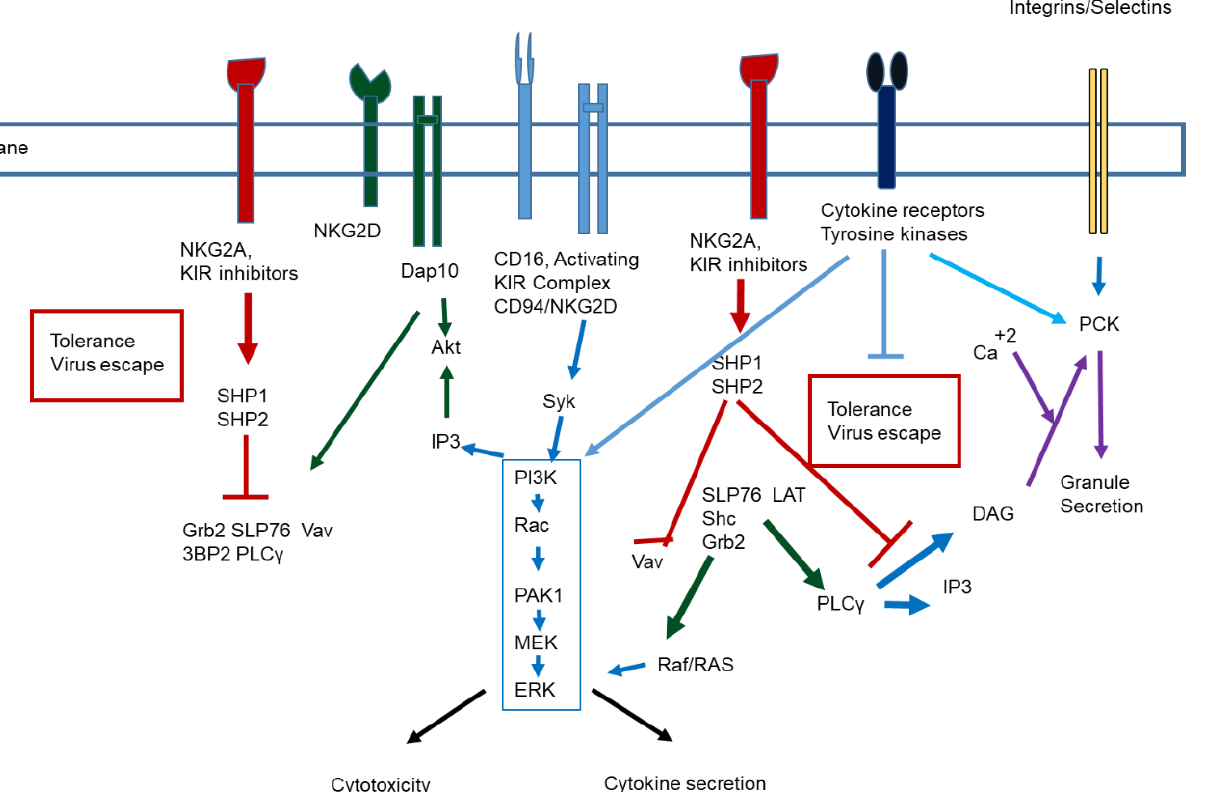
Figure 2. General signal transduction responses in NK cells. The figure represents the general involved in Nk cell responses. In essence, the difference in NK responses corresponds to the array of activating and inhibiting receptors. The blue and green lines represent activating signal pathways, and the red represents inhibitory signals. The green and the blue ways are similar; however, they depend on the activating receptors, NKG2D, CD160 or NCR. Activating cytokines receptors may play an important role in priming or enhancing the response of other receptors and the decrease in inhibitory receptors. Integrins and selecting activate PKC and enhance NK mobility and secretion.